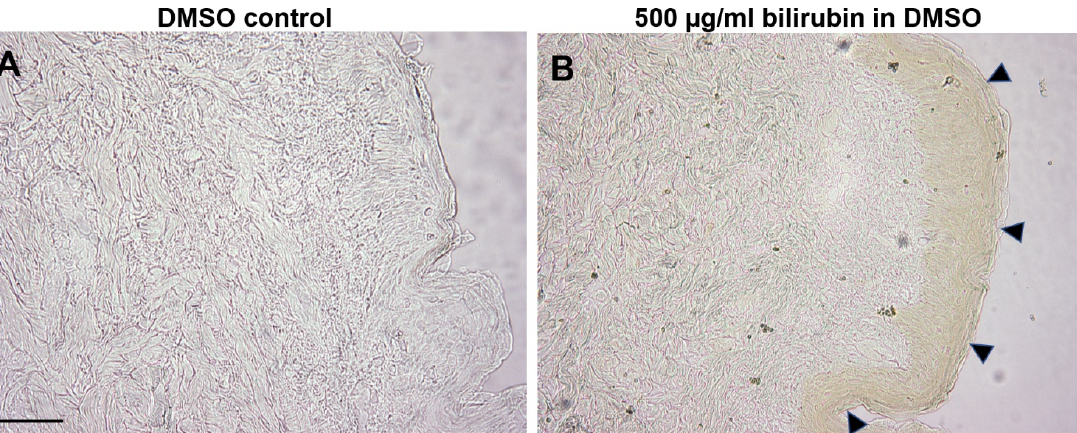
Figure 5. Bright-field microscopy of human abdominal skin section (8 µm) incubated with either ( A ) 100 µL of DMSO or ( B ) 500 µg/mL bilirubin dissolved in DMSO for 1 h in dark. Arrowheads indicate visible bilirubin (yellow color) accumulation in epidermal layer of skin section. Scale bar = 100 µm.